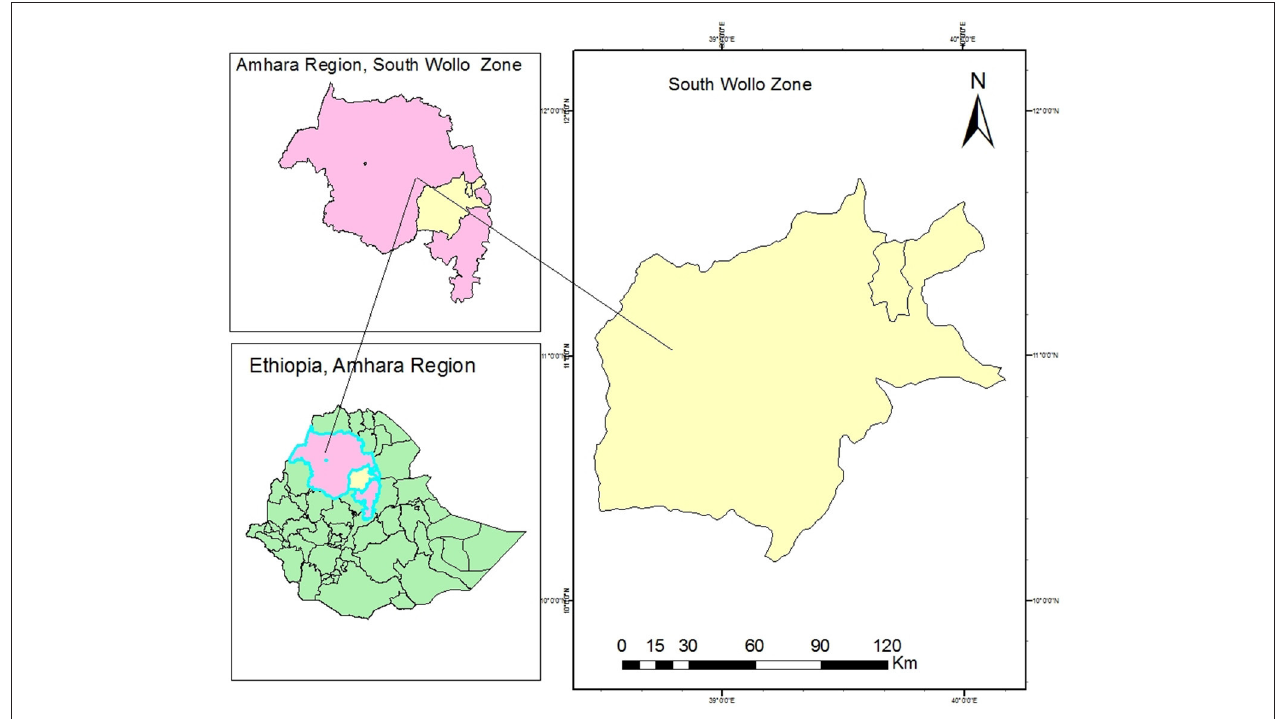
FIGURE 1 | Map of the study